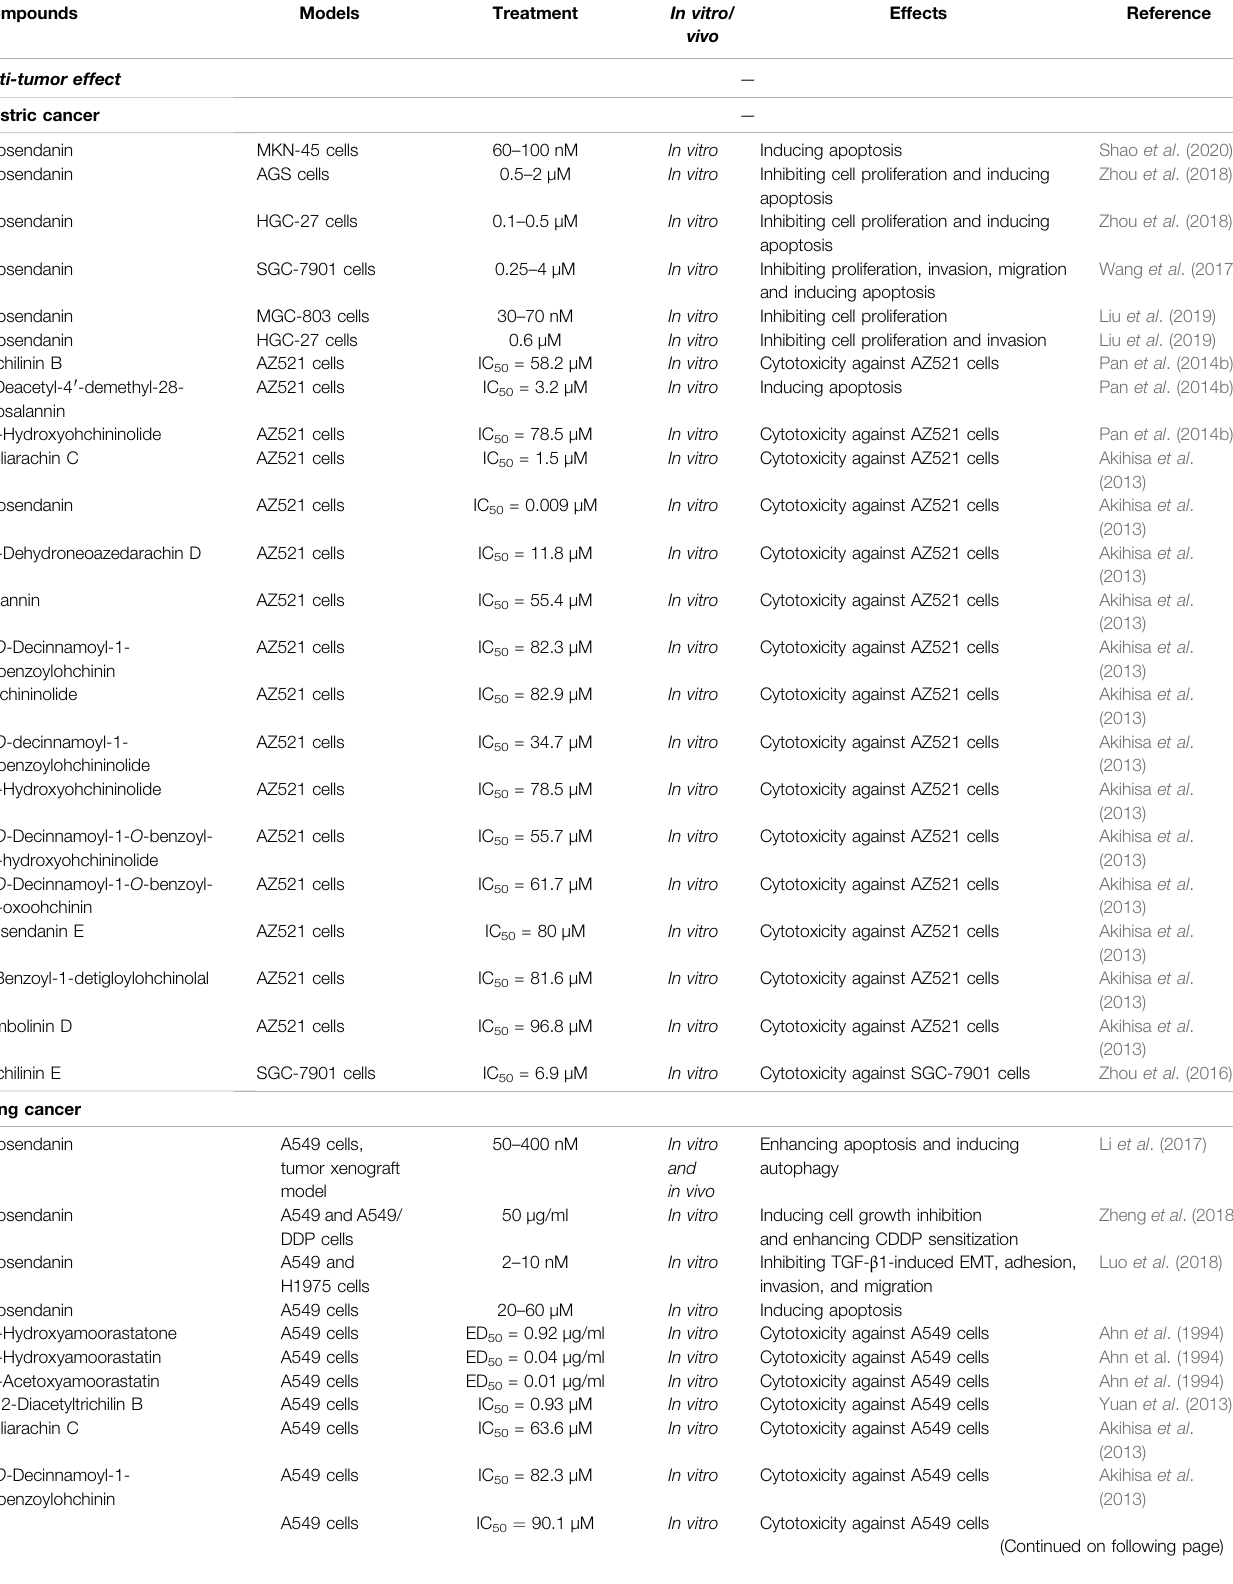
TABLE 2 | Pharmacological effects of